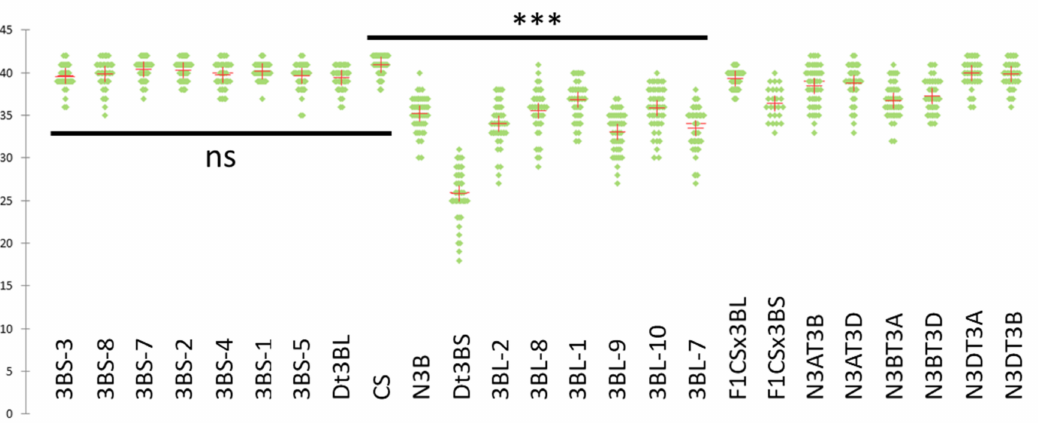
Figure 2. Average numbers of chiasmata (red crosses) for the various Chinese Spring lines: wild- type (CS), ditelosomic (Dt3BS and Dt3BL), deletion lines (3BS-xx or 3BL-xx for short and long arms respectively), hybrids between CS and Dt (F1xxx) and nulli-tetrasomics. ***: p <